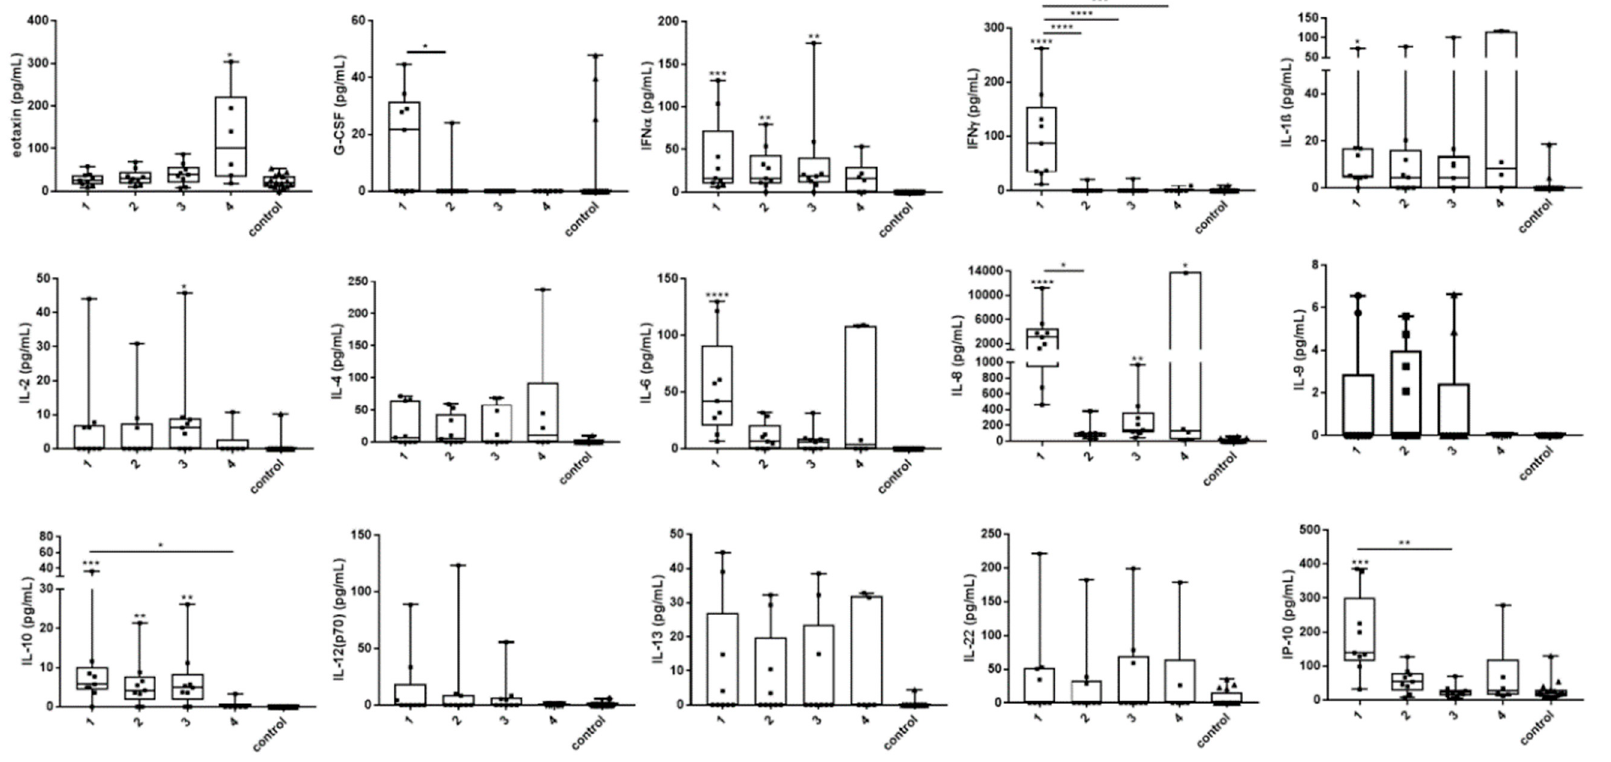
Figure 2. Changes of serum cytokine and chemokine levels in acute tularemia cases over time. Sera from nine patients diagnosed with acute tularemia and 16 sera from healthy blood donors (controls) were analyzed by bead-based LegendPlex assay. Time sampling points are shown on the X axis (1 – 3 represent 1, 2, and 3